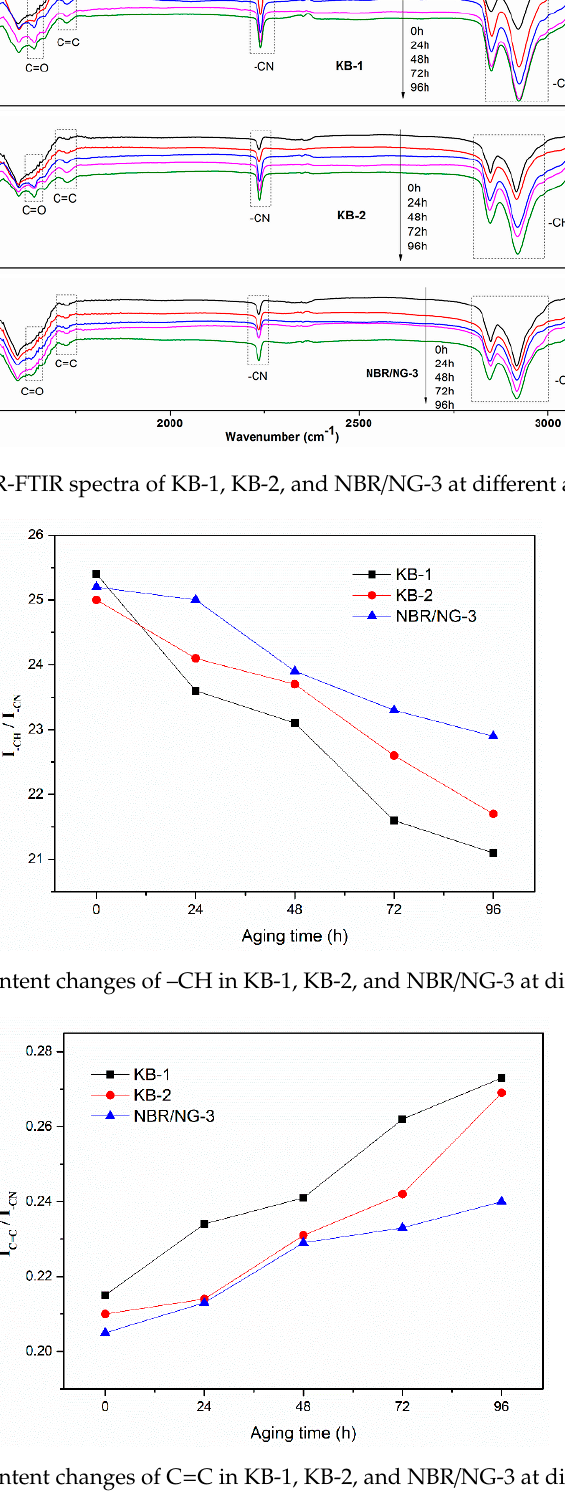
Figure 17. Relative content changes of C = C in KB-1, KB-2, and NBR / NG-3 at di ff erent aging times.